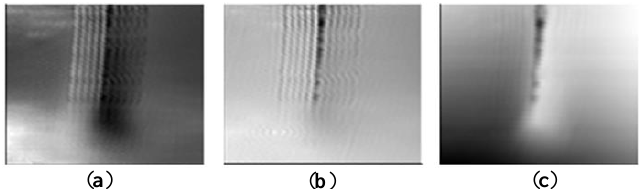
Figure 7. Original images of the portion of the covered crack under 50 × 70 scanning, obtained at three standoff distances: ( a ) 0.2 mm, ( b ) 0.8 mm, and ( c ) 1.7 mm.